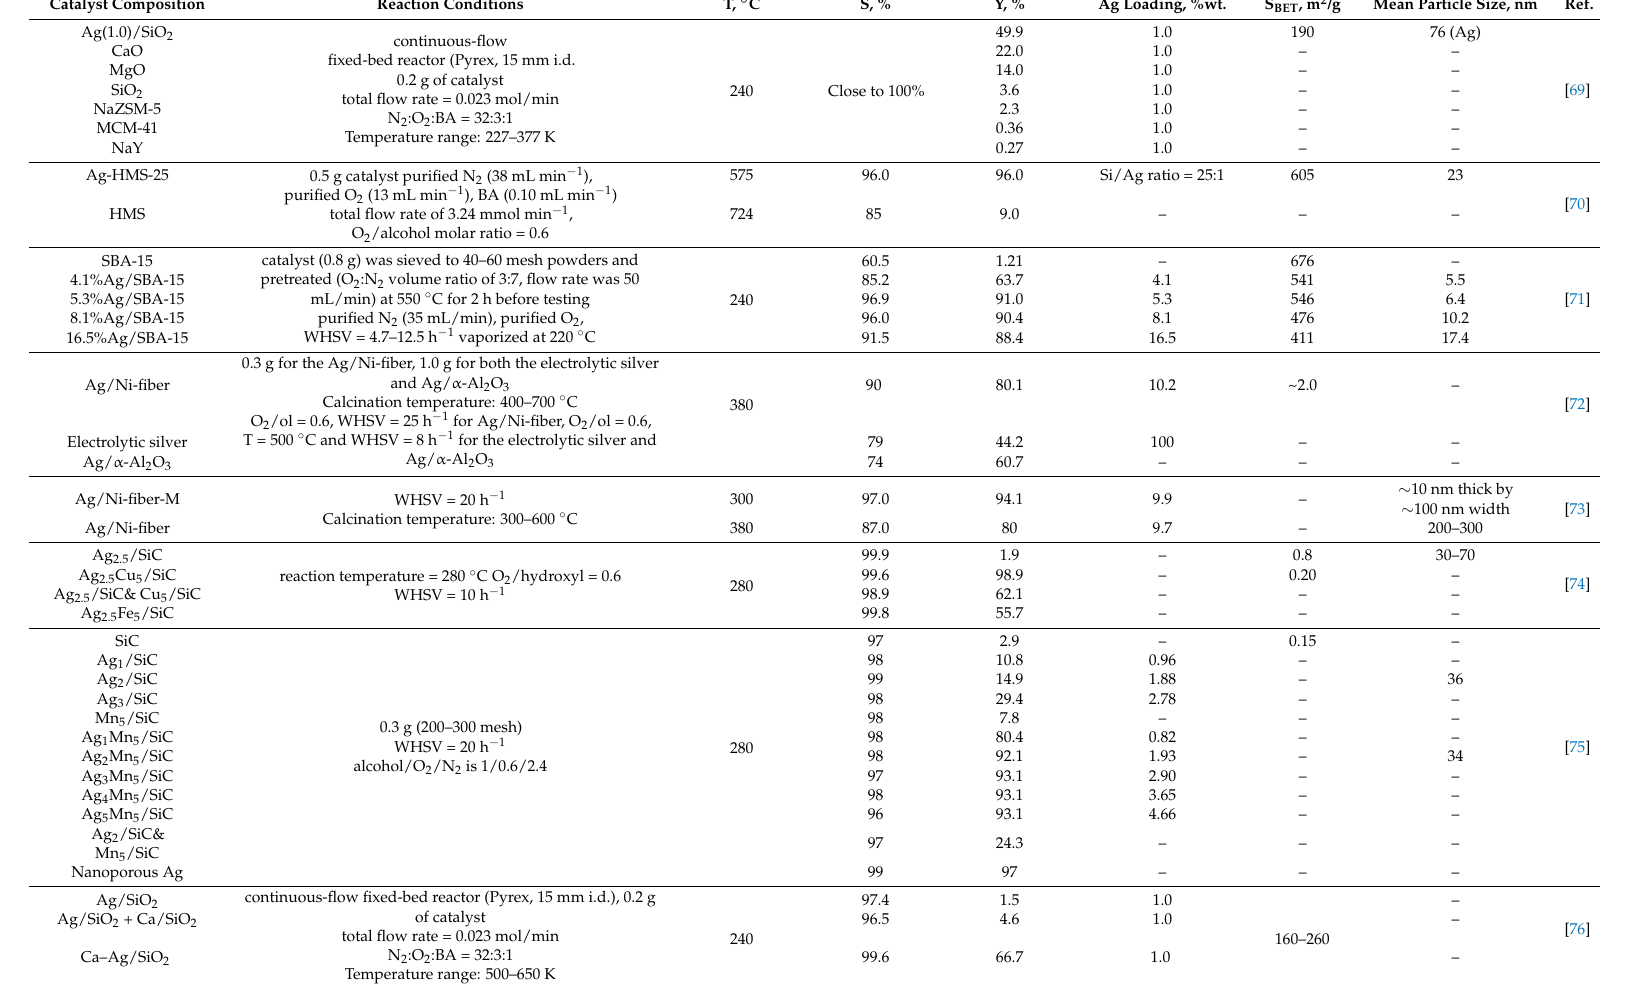
Table 3. Comparison of various Ag-containing catalysts for gas-phase BA